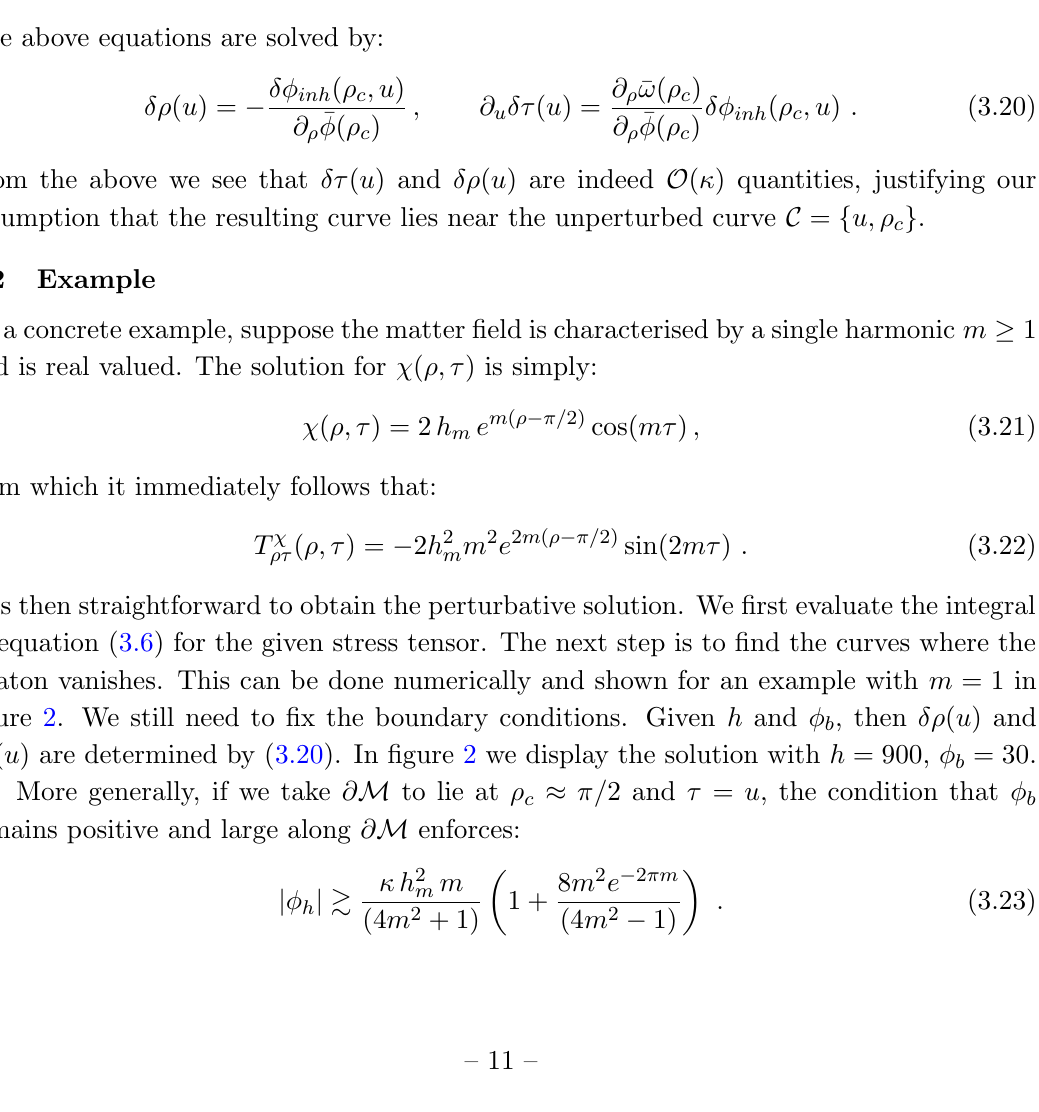
Figure 2 . The perturbative solution for m = (cid:0) (cid:30) h = 1. (a) shows the full perturbative solution on the unit disk, while (b) zooms in the interpolating region. The unperturbed interpolating geometry is given by a separation between negative (blue) and positive (yellow) curvature at (cid:26) = 0 (dashed, red circle). The perturbation for (cid:20)h 2 = 2 : 3, generates the new curve with (cid:30) = 0 that is given by 1 the black line in the plot. The black dashed line close to the boundary in (cid:12)gure (a) shows boundary conditions given by (cid:30) b = 30, h =